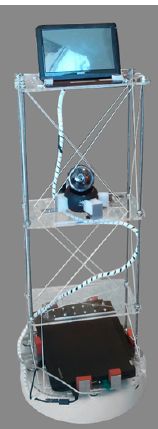
Figure 2. A prototype of the proposed home robot. The system consists of a IRobot Create 2, a laptop computer that was used as a control unit, a Logitech Quickcam Orbit web-camera, and a Mimo Um-720s